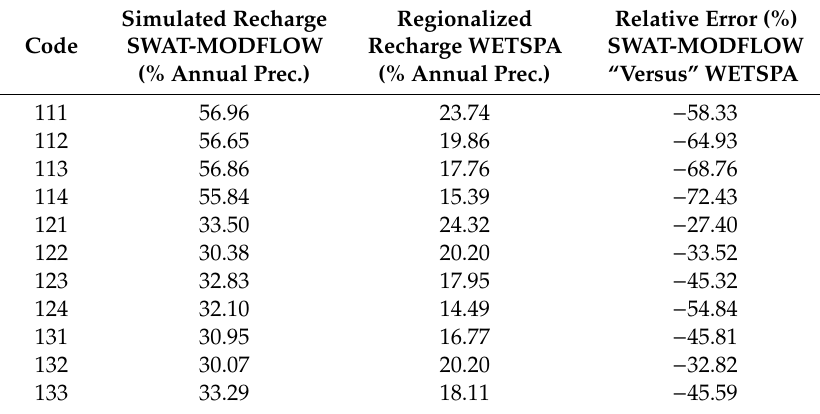
Figure 6. ( a ) Relative error of the regionalized recharge and its relation with the factors ( b ) “slope”, ( c ) “soil class”, and ( d ) “land use / cover”. Table 1. Potential recharge rates for each combination of “soil class”, “land use / cover”, and “slope” for the Cerrado Biome in the Federal